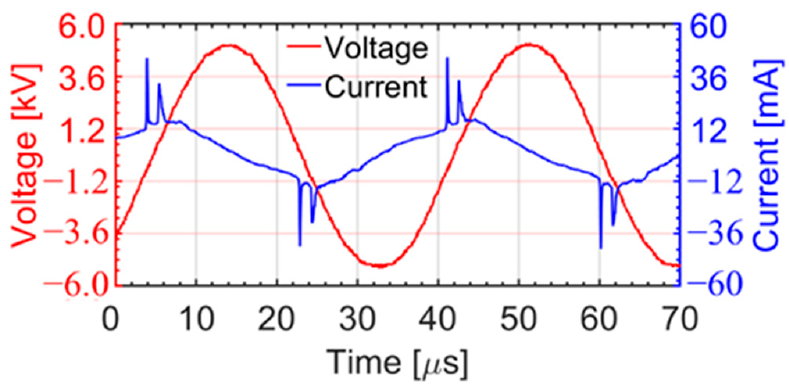
Figure 4. Current and voltage waveforms of the plasma jet during plasma activation of DIW.